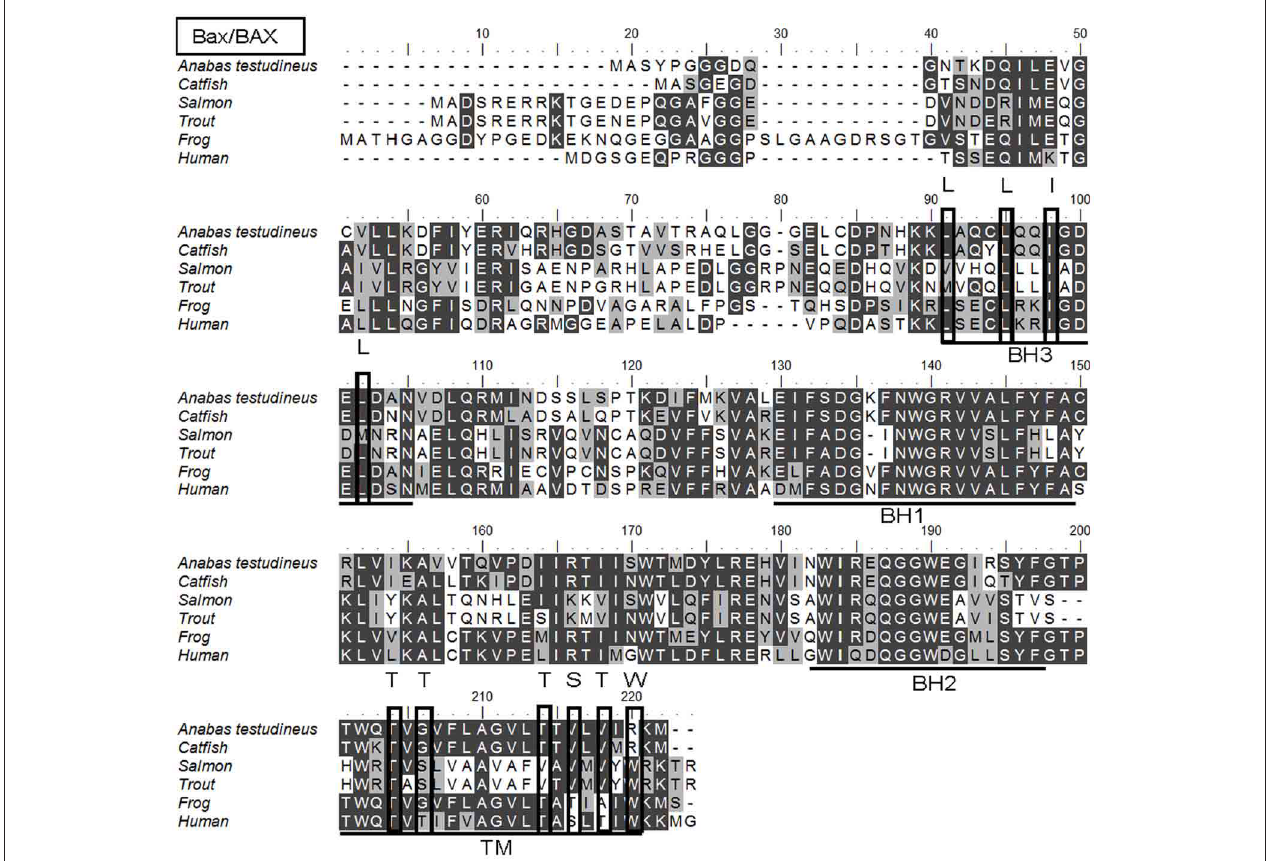
FIGURE 6 | A multiple alignment of the deduced amino acid sequence of Bcl-2 associated X protein from gills of Anabas testudineus (Genbank accession number KC513734) with those from Homo sapiens (human; NP_620116.1), Mus musculus (mouse; NP_031553.1), Canis lupus familiaris (chicken; NP_001003011.1), Xenopus (Silurana) tropicalis (frog; NP_989185.1), Salmo salar (salmon; ACI67445.2), Oncorhynchus mykiss (trout; ACO08752.1), and Ictalurus punctatus (catfish; NP_001187866.1). Identical amino acids are indicated by shaded black residues and similar